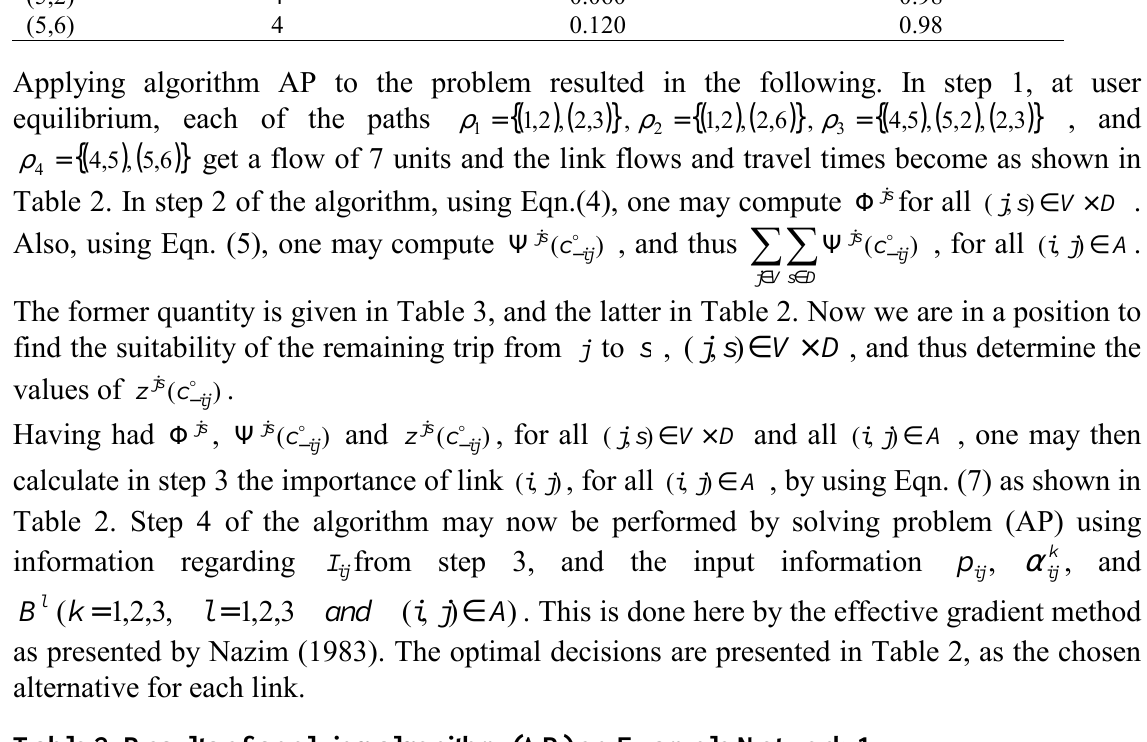
Table 2. Results of applying algorithm (AP) on Example Network 1. Link ),(